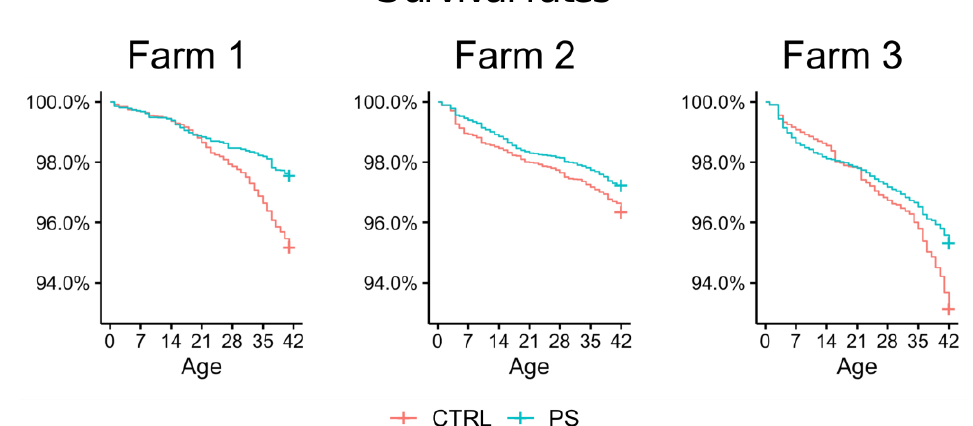
Figure 3. Kaplan–Meier survival estimates showing the mortality rates observed throughout the productive cycle in treated (PS) and control (CTRL) groups of each of the three